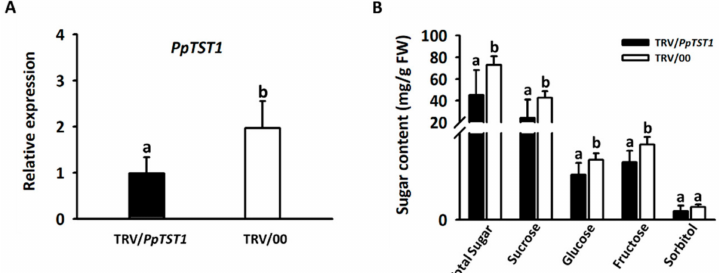
Figure 5. Functional analysis of the PpTST1 gene using the virus-induced gene silencing (VIGS) system in peach fruits. ( A ) expression of PpTST1 in peach fruit injected with pTRV2-PpTST1 / pTRV1 and pTRV2 / pTRV1 (control), respectively. ( B ) sugar accumulation in peach fruit injected with pTRV2-PpTST1 / pTRV1 and pTRV2 / pTRV1, respectively. Di ff erent lowercase letters indicate significant di ff erences between fruits injected with pTRV2-PpTST1 / pTRV1 and pTRV2 / pTRV1 (Student’s t test at p < 0.05). pTRV2-PpTST1 / pTRV1 and pTRV2 / pTRV1 are indicated with TRV / PpTST1 and TRV / 00, respectively. Error bars represent standard error (SE) of three biological